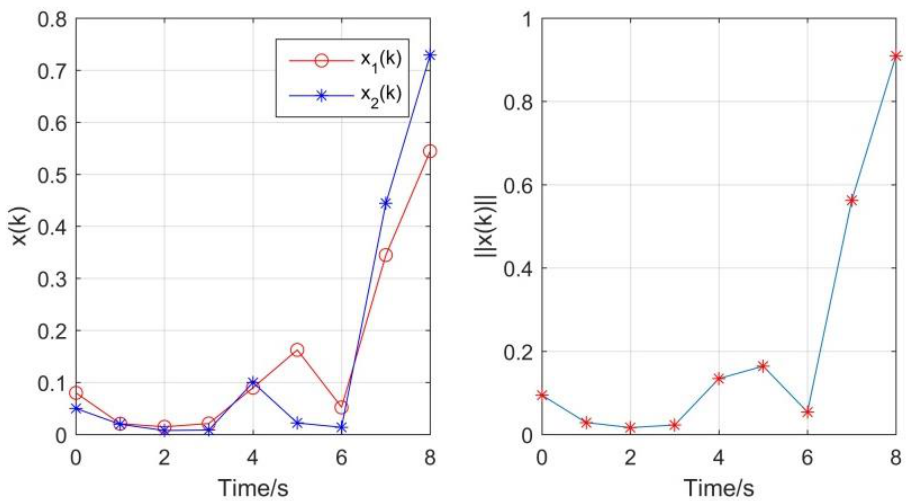
Figure 8. State trajectories of x ( k ) ( left ) and trajectories of (cid:107) x ( k ) (cid:107) ( right ).